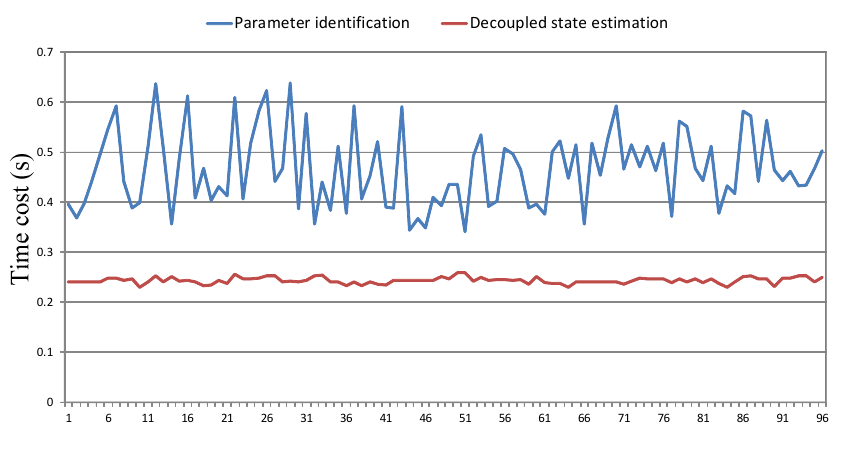
Figure 5. Comparison of calculation speeds between PEI and